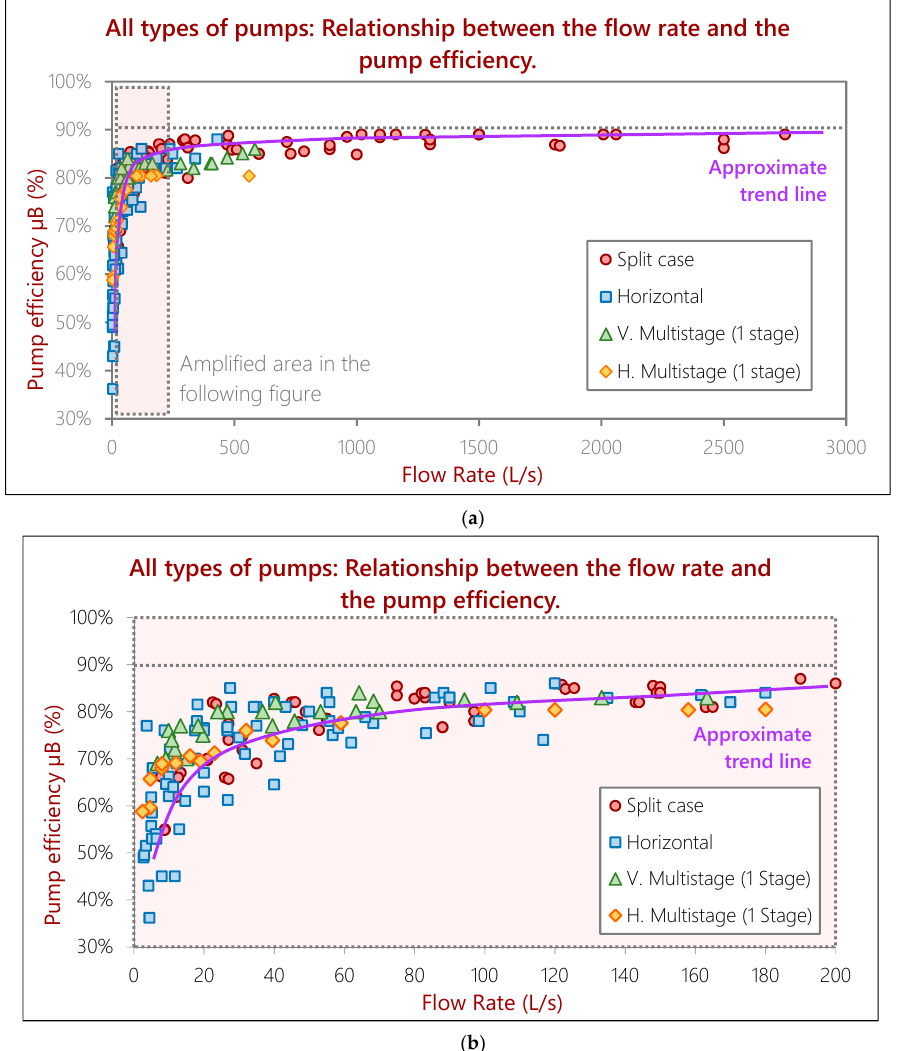
Figure 1. ( a ). Optimum pump efficiency and the correspondent flow rate at that operating point, classified by the pump type. ( b ) Detail of the previous figure for smaller discharges.